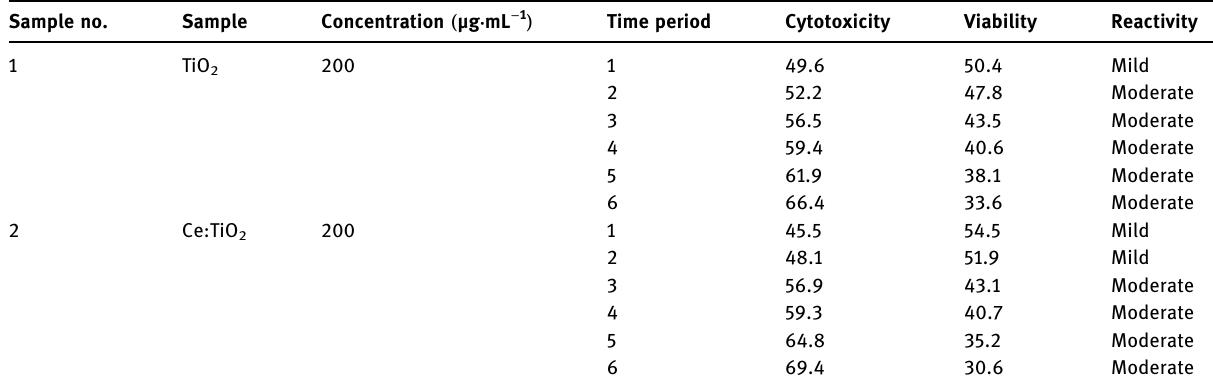
Table 1: Anticancer activity of pure and Ce - doped TiO 2 Sample